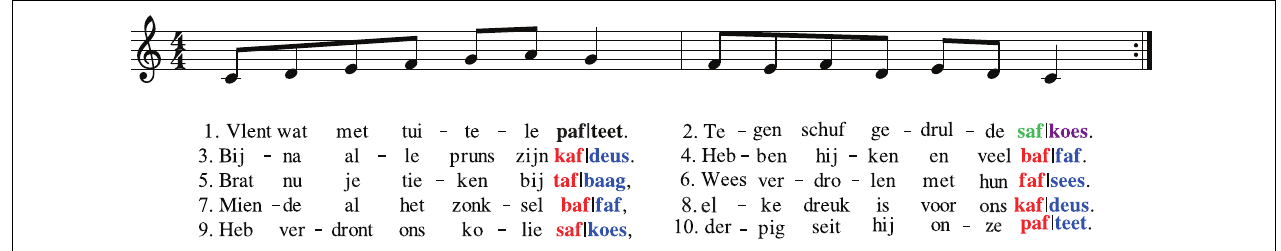
FIGURE 1 | Example Stimulus. Song with lyrics in non-sense Dutch. Critical pseudo-words used to assess the rhyme sensitivity effect at the end of phrase 2 of the songs highlighted in green (rhyme) and purple (non-rhyme); Critical pseudo-words to assess the rhyme repetition effect from phrase 3 to 10 of the songs are highlighted in red (rhyme) and blue (non-rhyme). Stimuli were taken from Hahn et al. (2018). For the analysis, the first phrase-final pseudo-word of every song (in bold) was disregarded, as this cannot rhyme.